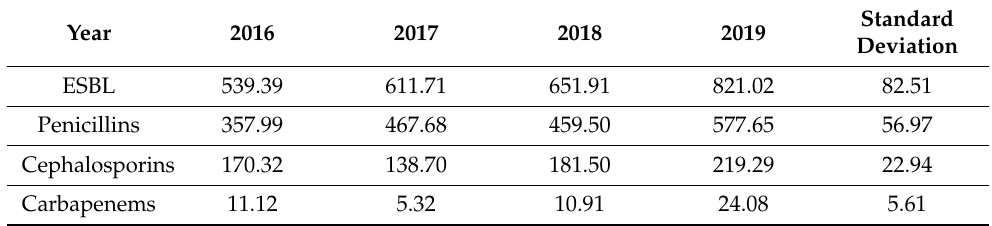
(ESBL): Extended Spectrum